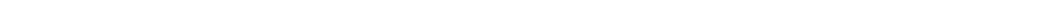
Fig. 4 Single-nucleotide polymorphisms in ZIKV populations infecting monkeys and mosquitoes in this study. We used Illumina deep sequencing to characterize viral genomic diversity in a saliva samples from mosquitoes that fed on ZIKV-infected Ifnar − / − mice, b monkeys infected via mosquito bite, and c monkeys inoculated subcutaneously with ZIKV-PRVABC59 stock. Purple symbols represent individual saliva samples, blue symbols represent animals that were infected via exposure to ZIKV-infected Aedes aegypti , and orange symbols represent animals infected via subcutaneous injection. Frequencies of SNPs detected in the stock virus isolate are plotted in each panel for reference. Viruses infecting monkeys were sequenced at the time of peak plasma viremia: day 3 post-infection in sc-inoculated animals and days 5 or 6 post-feeding in mosquito-bitten animals. Plotted frequencies represent the average of 2 technical replicates for each